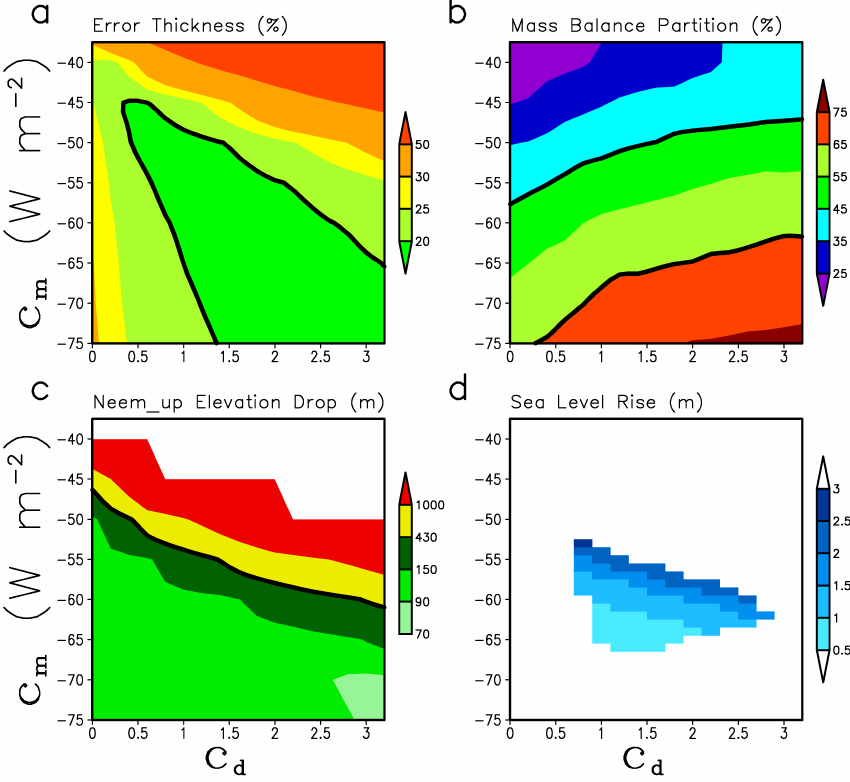
Figure 5. Estimated constraints on the parameters c d (ice discharge) and c m (surface melt) illustrated with our ensemble simulations together with our estimate of the GrIS contribution to Eemian sea-level rise. (a) Relative error in ice thickness (%). (b) Mass balance partition (%). (c) Maximum elevation reduction during the Eemian compared to present day, 200km upstream from NEEM (m). Here, regions where no Eemian ice is simulated at the upstream position of NEEM are displayed in white. (d) Simulated contribution of the Greenland ice sheet to sea-level rise between the Eemian and present day under our constraints. The black lines in (a) – (c) indicate our constraints: error values < 20% for ice thickness, a 45 to 65% range for mass balance partition and an Eemian to present-day surface elevation reduction of < = 430m at the upstream position of